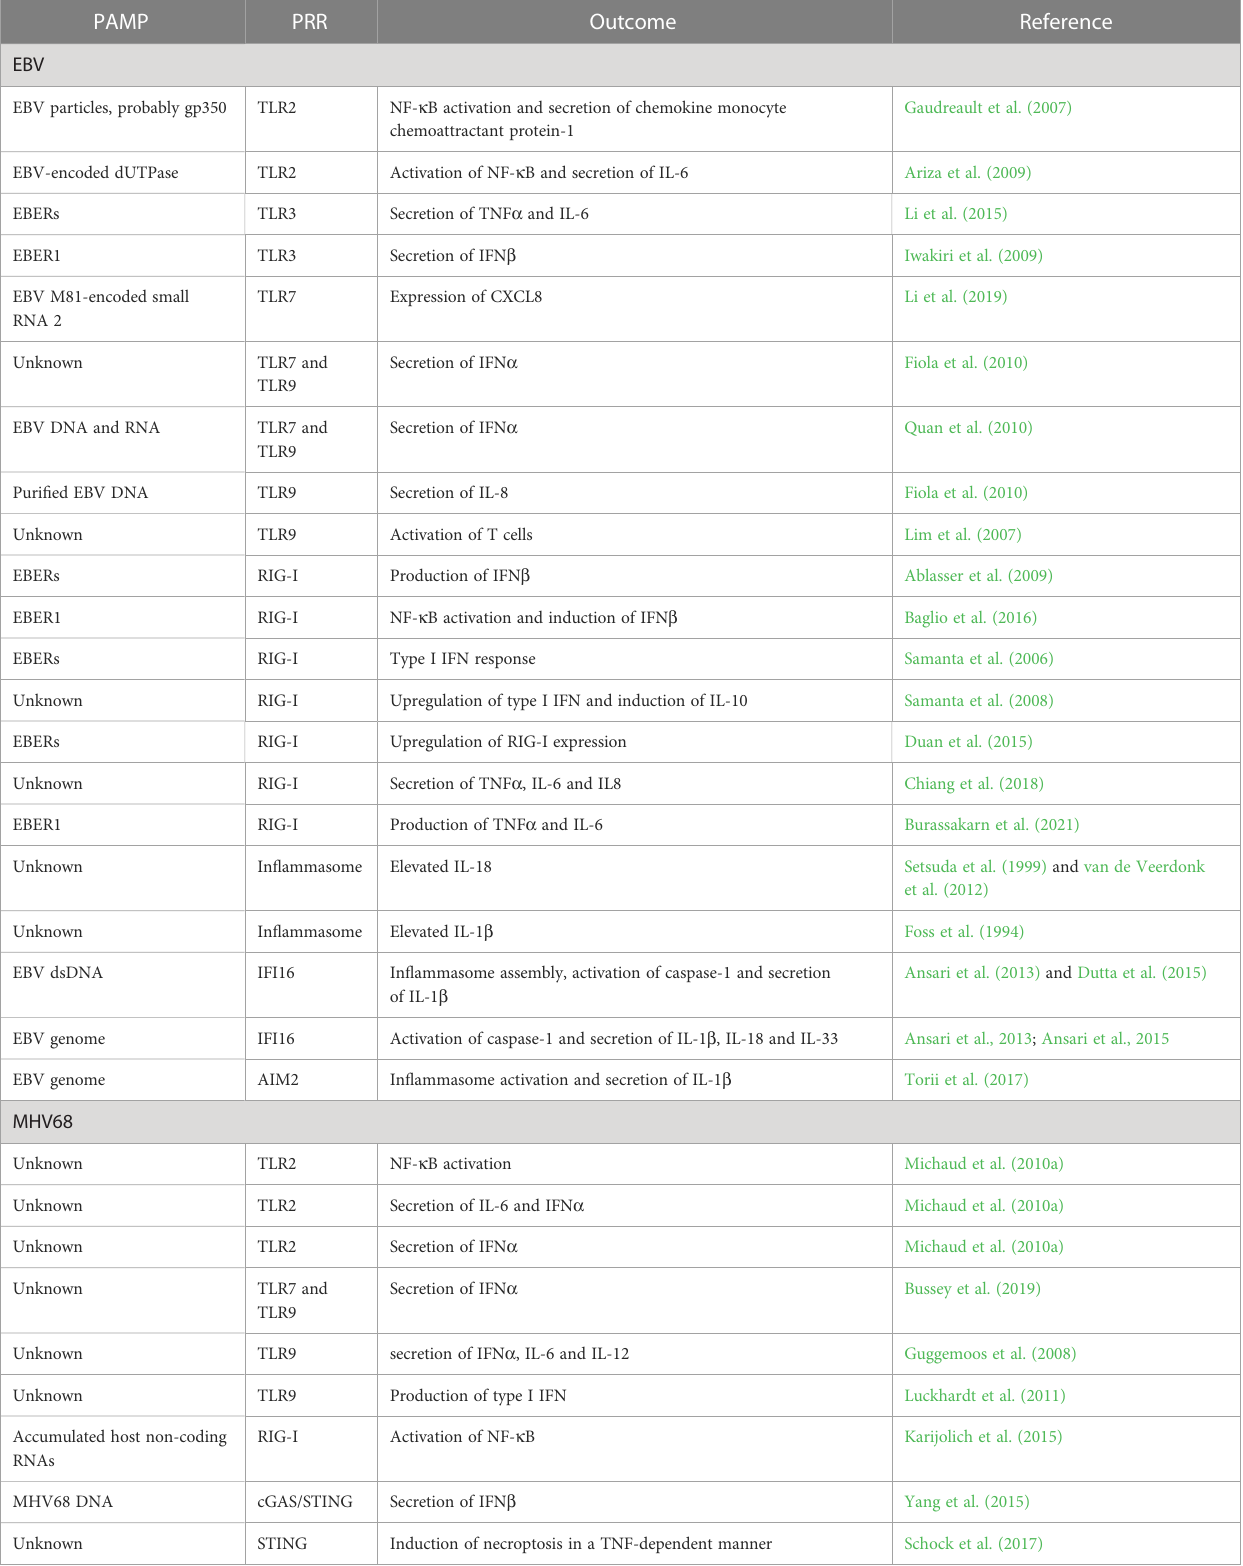
TABLE 1 Activated innate immunity pathways after EBV and MHV68